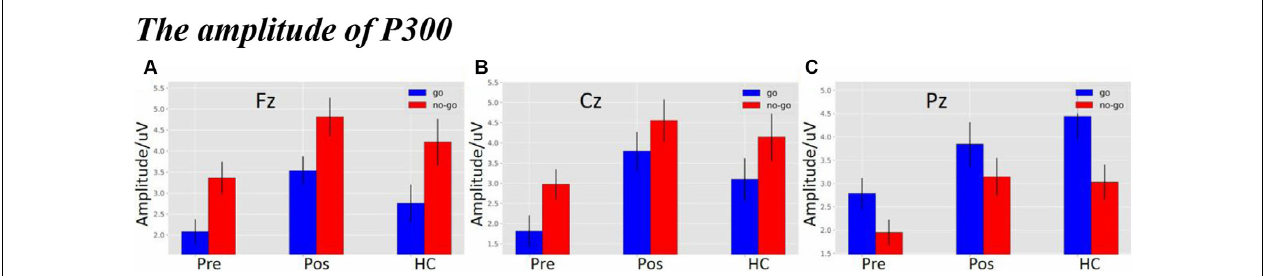
FIGURE 4 | (A) The P300 amplitude among three groups under three different types of stimuli at Fz electrode. (B) The P300 amplitude among three groups under three different types of stimuli at Cz electrode. (C) The P300 amplitude among three groups under three different types of stimuli at Pz electrode (the time window of P300; pre, pre-operative group; post, post-operative group; HC, healthy control